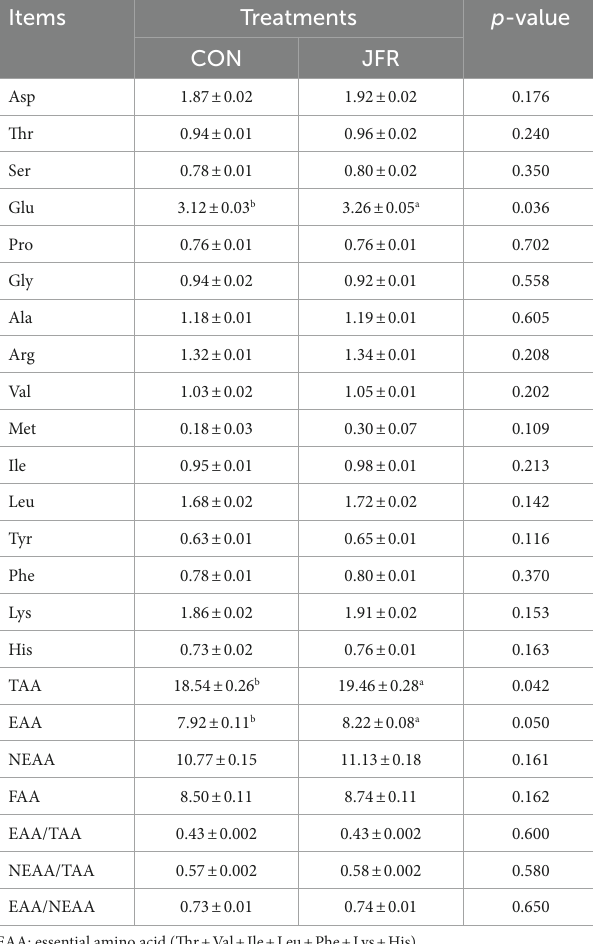
TABLE 4 Effect of dietary jasmine flower residue supplementation on the fatty acid composition.